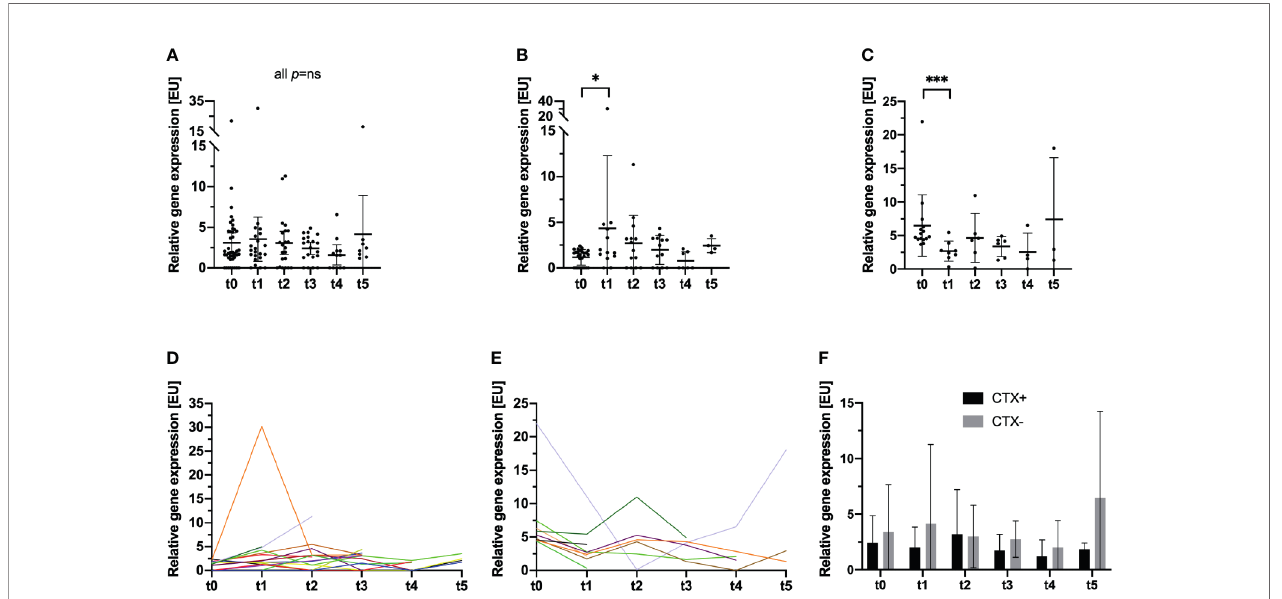
FIGURE 3 | Longitudinal analysis of blood samples of 47 CRC patients for the incidence and relative enumeration of CTC by a semi-quantitative CK20 RT-qPCR. Results are expressed by expression units [EU]. The bar represents the mean relative CTC count expressed by [EU]. (A) The entire study cohort is analyzed, and no statistically signi fi cant deviations of the relative CTC count compared to t0 were monitored. (B – E) The previously reported clinically signi fi cant cut-off value for CTC detection by CK20 PCR in CRC patients (13) was applied and the cohort strati fi ed for further analysis. (B, D) In patients, who were below the cut-off at t0, a signi fi cant increase in CTC at t1 was monitored (p=0.047). No further differences were monitored at later visits compared to t0. Each color represents an individual patient. (C, E) For patients who were above the cut-off at t0, a signi fi cant decrease in the relative CTC quantity was recorded (p<0.001). No further signi fi cant deviations were monitored at later visits. (F) Patients were strati fi ed and subdivided according to their necessity of adjuvant chemotherapeutic treatment (CTX+). Patients that did not require adjuvant treatment were grouped in the follow-up subset (CTX-). *p ≤ 0.05; ***p ≤